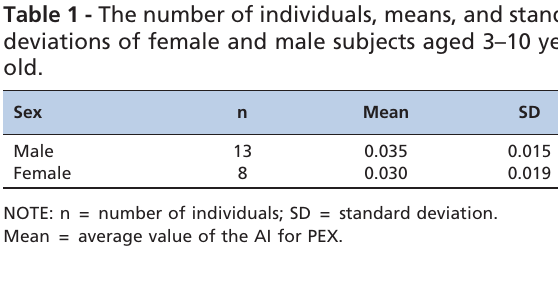
Table 2 - The number of individuals, means, and standard deviations of female and male subjects aged 11 – 20 years old.